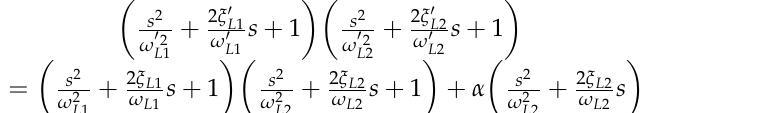
Figure 6. The condensed control block diagram of the thrust vector dynamics.